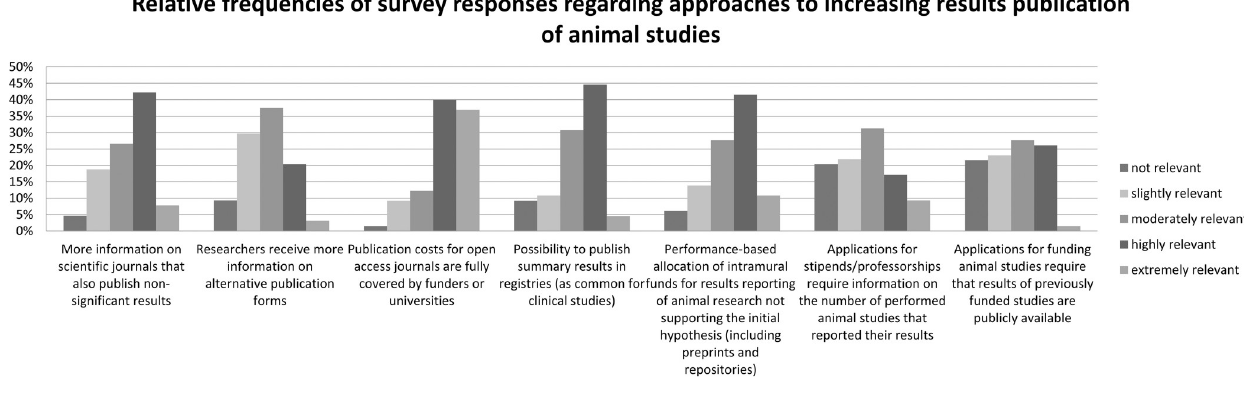
Fig 1. Relative frequencies of survey